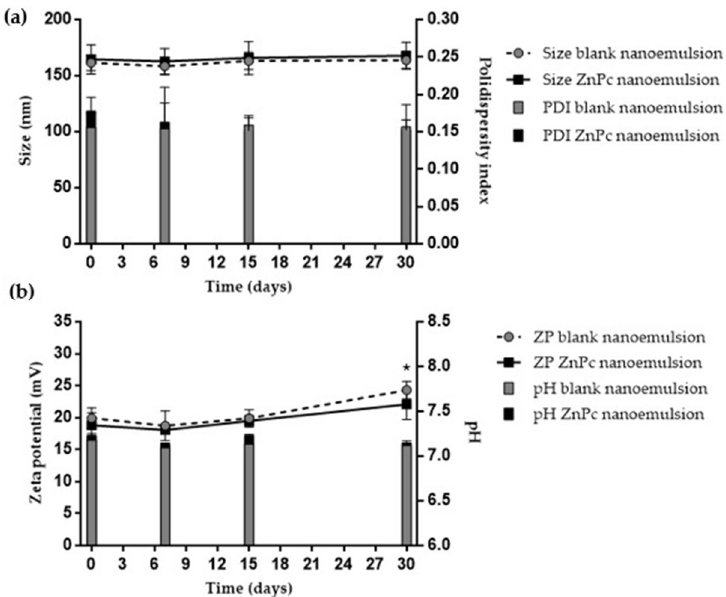
Figure 5. Physical stability of the blank and ZnPc nanoemulsion during 60 days of storage at 4 °C for: ( a ) Size and polydispersity index (PDI), ( b ) Zeta potential and pH. Statistical analysis was performed by size, PDI and zeta potential * indicates statistical difference in relation to time 0 (ANOVA with Tukey’s post hoc test, p < 0.05).